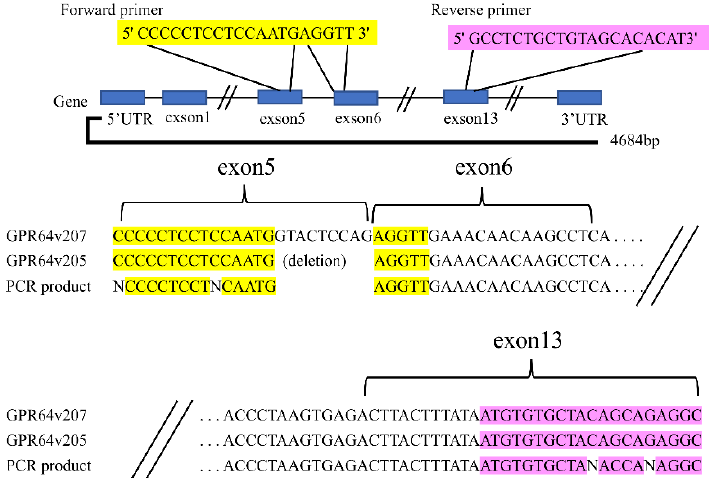
Figure 1. Direct sequencing of PCR products shows consistent results with the GPR64v205 reference sequence.